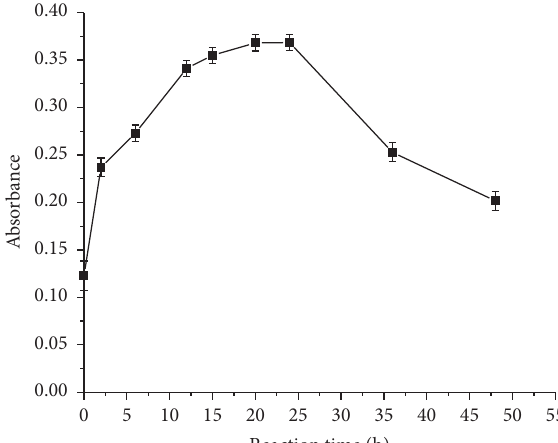
Figure 4: Effect of reaction time on the determination of fluoride by EBT as a spectrophotometric reagent (conditions: pH � 5.0 and concentration of aluminum and EBT: 5.0 × 10 − 5